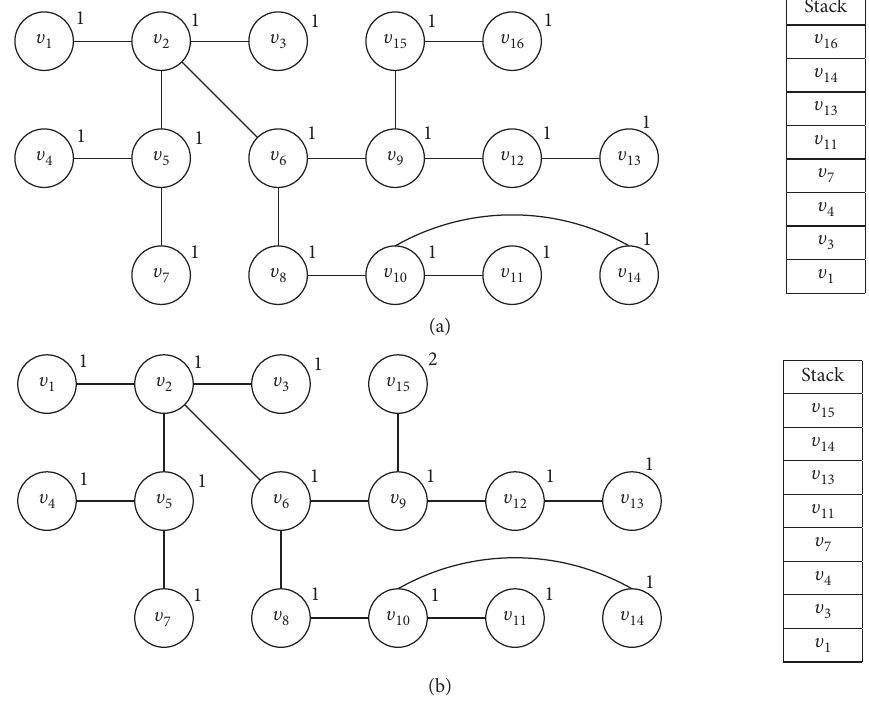
Figure 1: A tree with the Wiener index